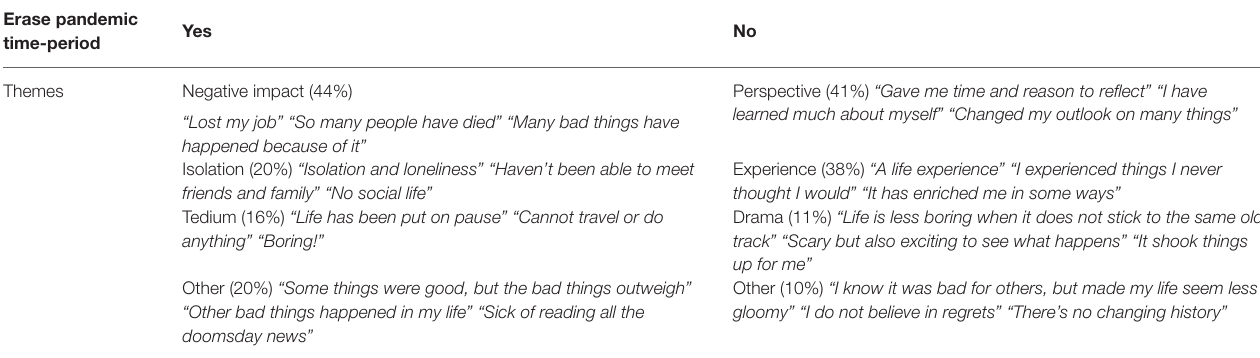
TABLE 4 | Motivations to erase the pandemic time-period or not from one’s lifeline, Study 1. Erase pandemic Yes time-period